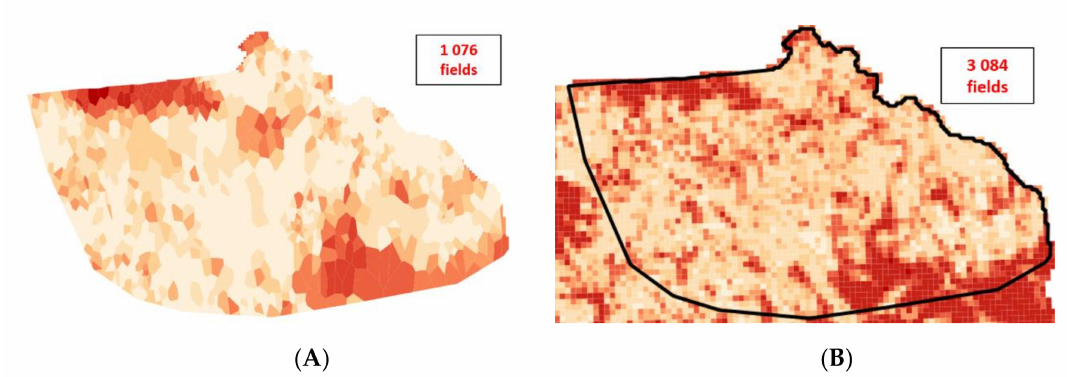
Figure 13. Comparison of maps created using Voronoi polygons ( A ) and square primary fields ( B